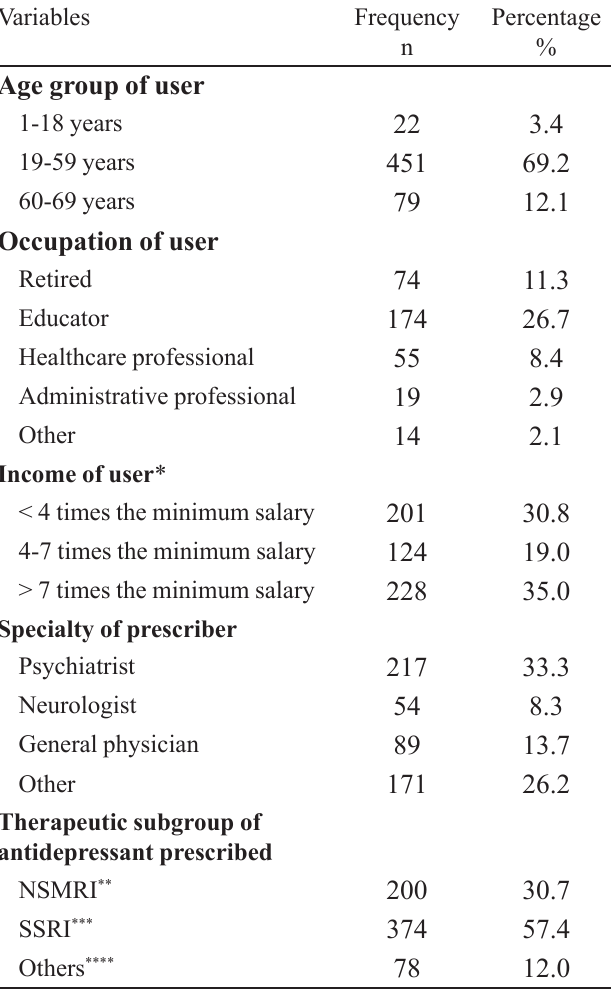
TABLE I - Characteristics of users, prescribers and medications